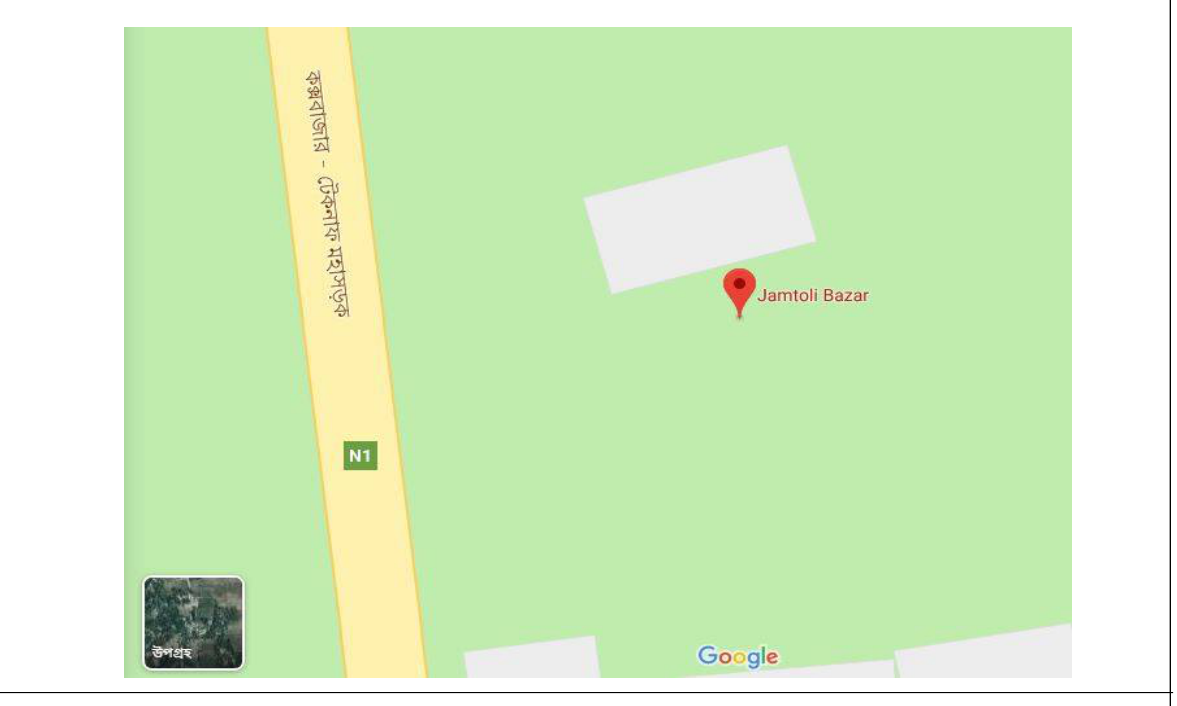
Figure 1: Jamtoli Rohingya camp, Teknaf, Cox’s